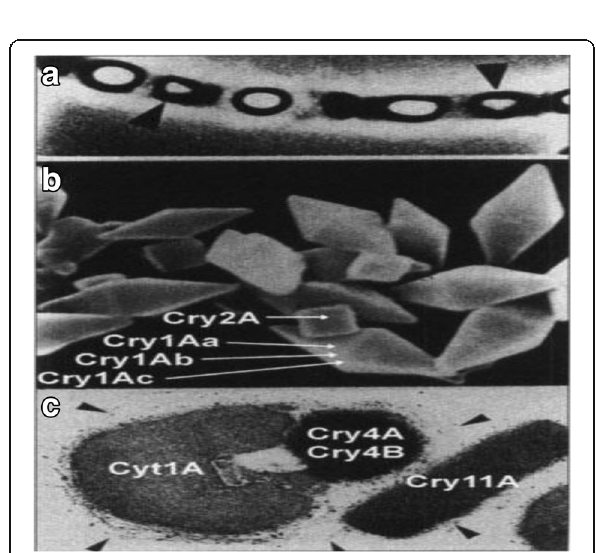
Fig. 2 Crystal of Bt kurestaki and Bt israelinsis “ From Hofte and Whitely (1989) ” . a Bt spore. b Crystal of Bt kurestaki. c Crystal of Bt israelensis. The arrows in a illustrating the endospore (on the left) and the crystal (on the right)